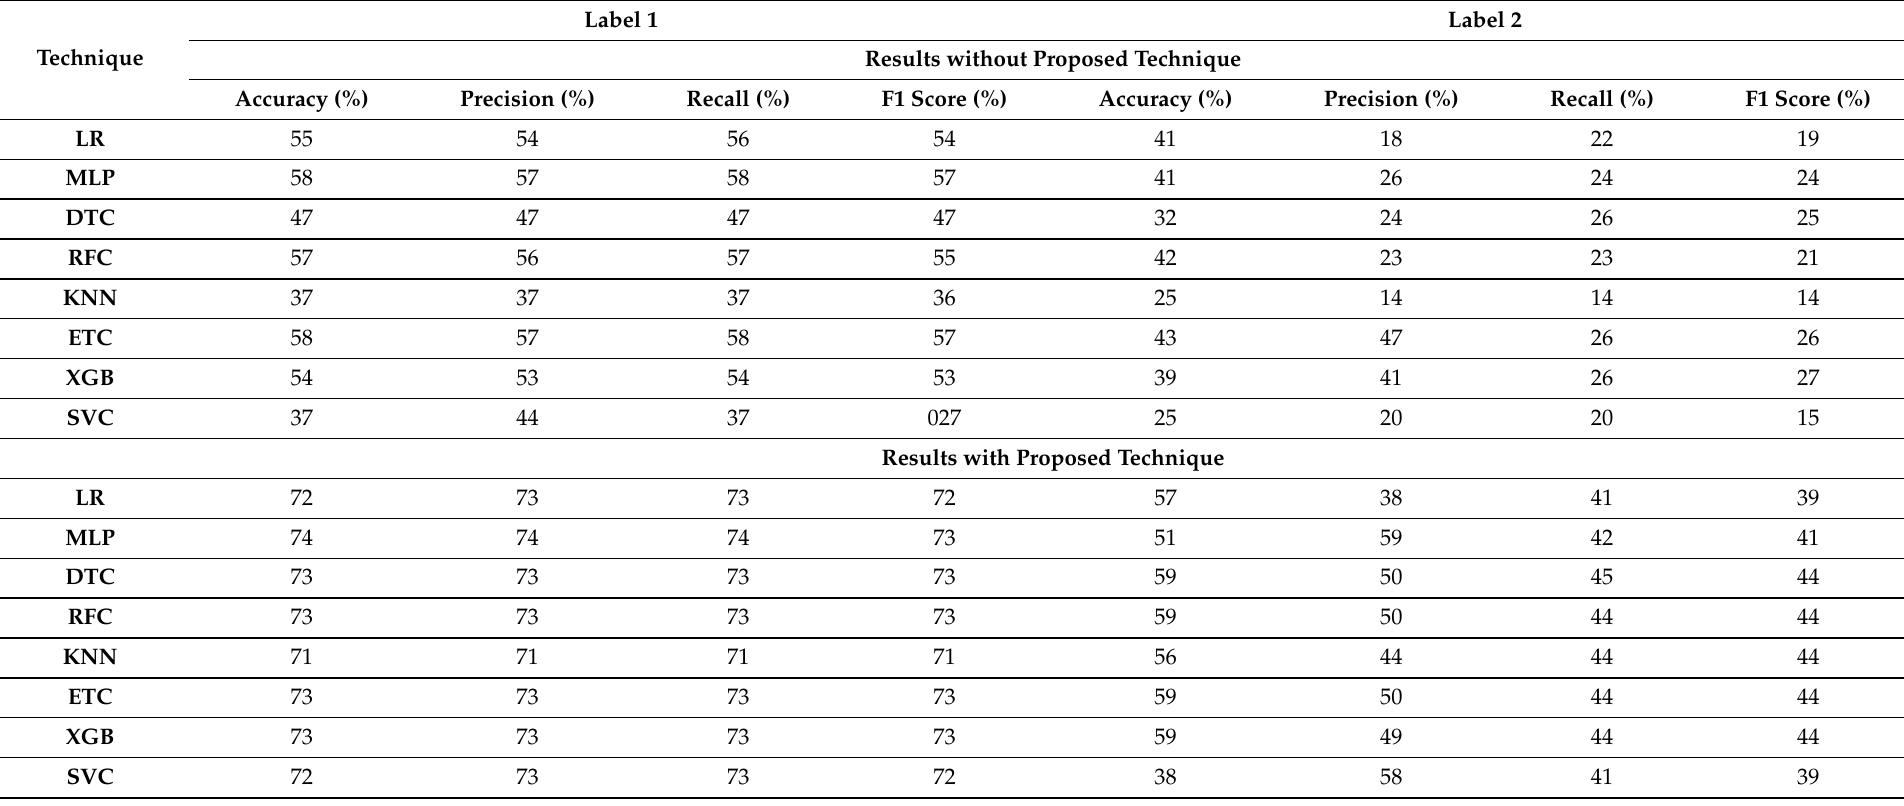
Table 12. Comparative analysis of applied machine learning models using a balanced dataset with a data split of